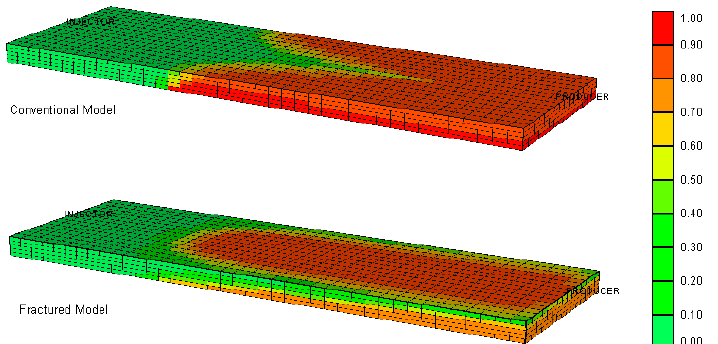
Figure 5. Oil saturation profile for conventional ( top ) and fractured ( bottom ) models. Red refers to oil saturations, whereas green refers to the depleted zoned (So = 0) [70].